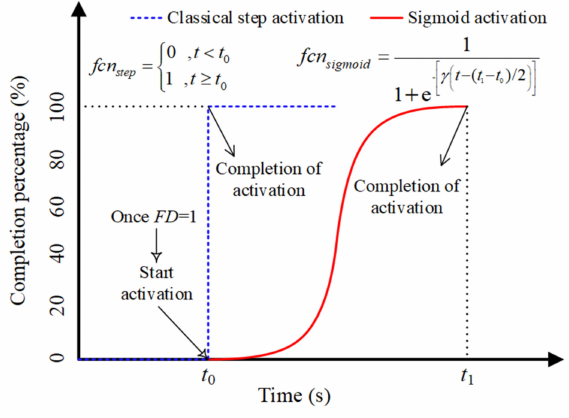
Figure 7. Illustrations of activation functions for